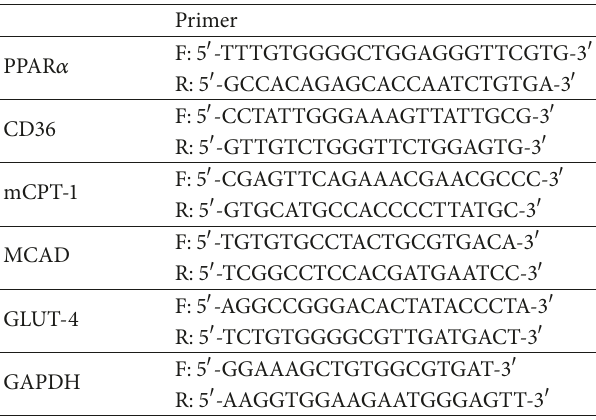
Table 1: Primers for real-time PCR.